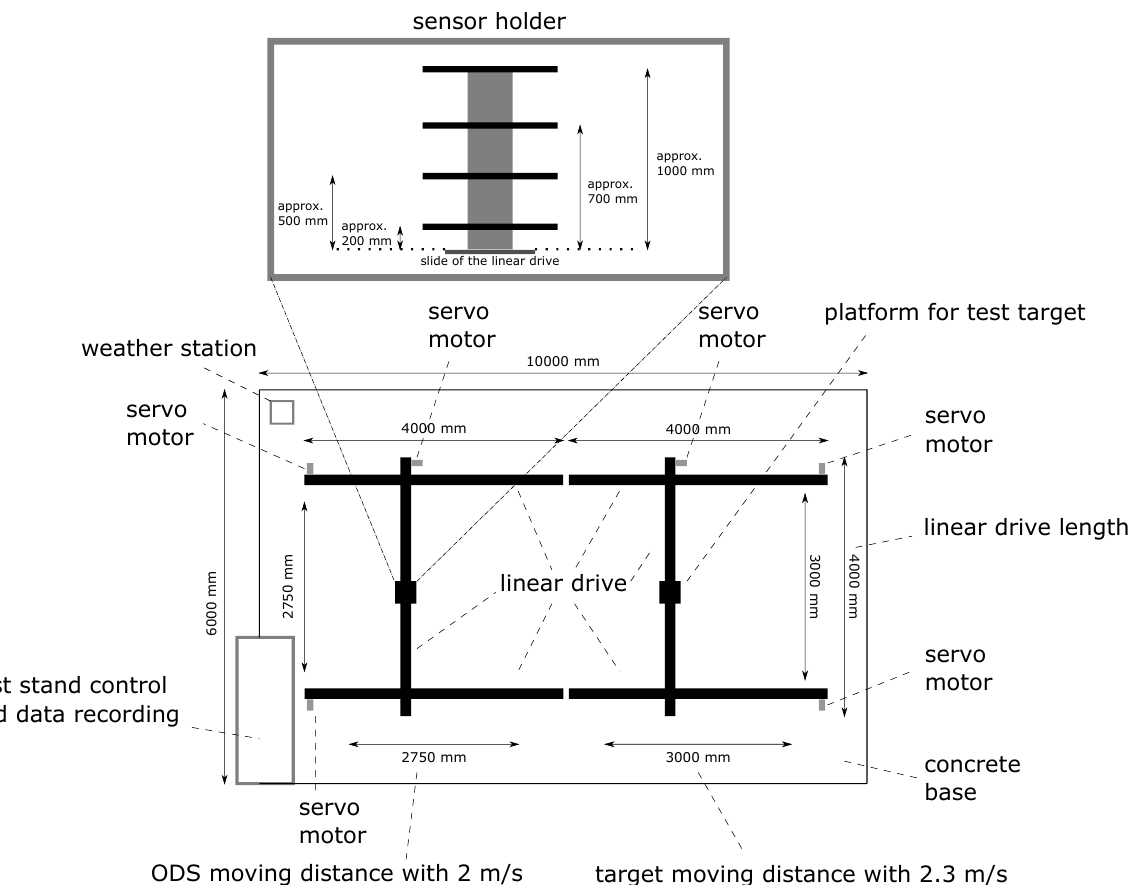
Figure 4. Top view in a schematic drawing of the test stand is shown and gives an overview of the dimensions of the test stand and the traverses of the object detection system (ODS) and target. The structure of the sensor holder is also